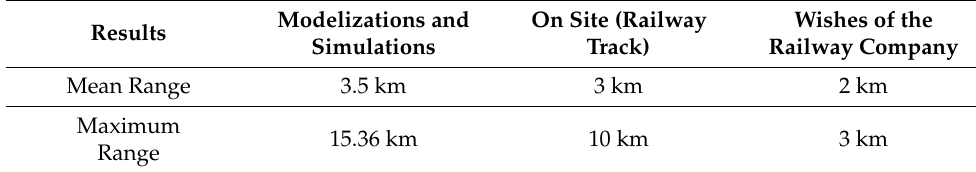
On Site (Railway Wishes of the Track) Railway Company